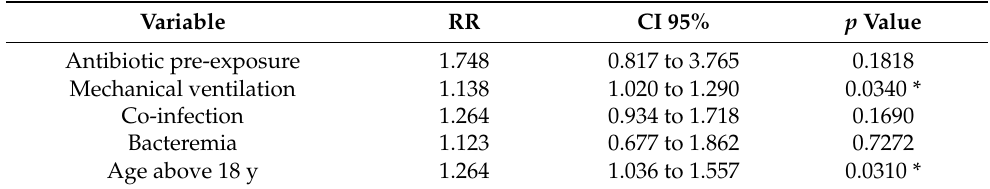
Table 4. Risk factors and relative risk of mortality among ICU patients with S. maltophilia respiratory infections.